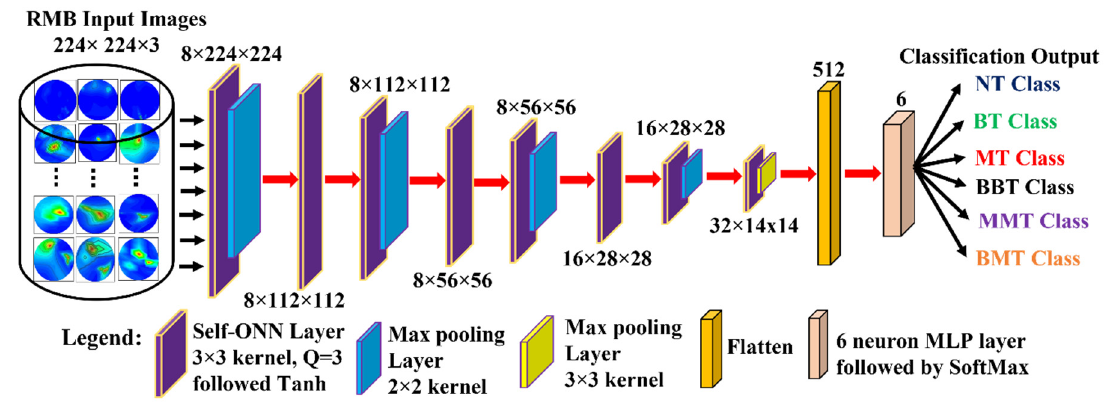
Figure 7. Proposed Microwave Brain Image Network (MBINet) model using Self ‐ ONN.